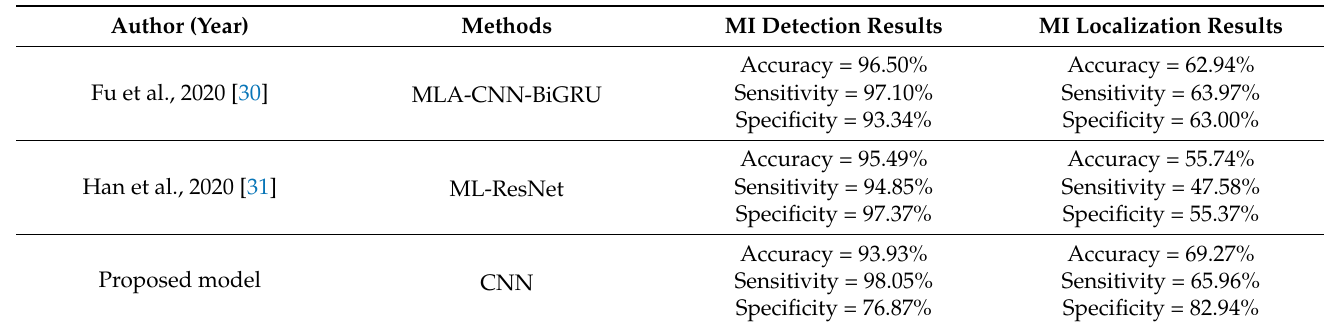
Table 10. Comparison of classification performance between our method and the existing methods under Setting